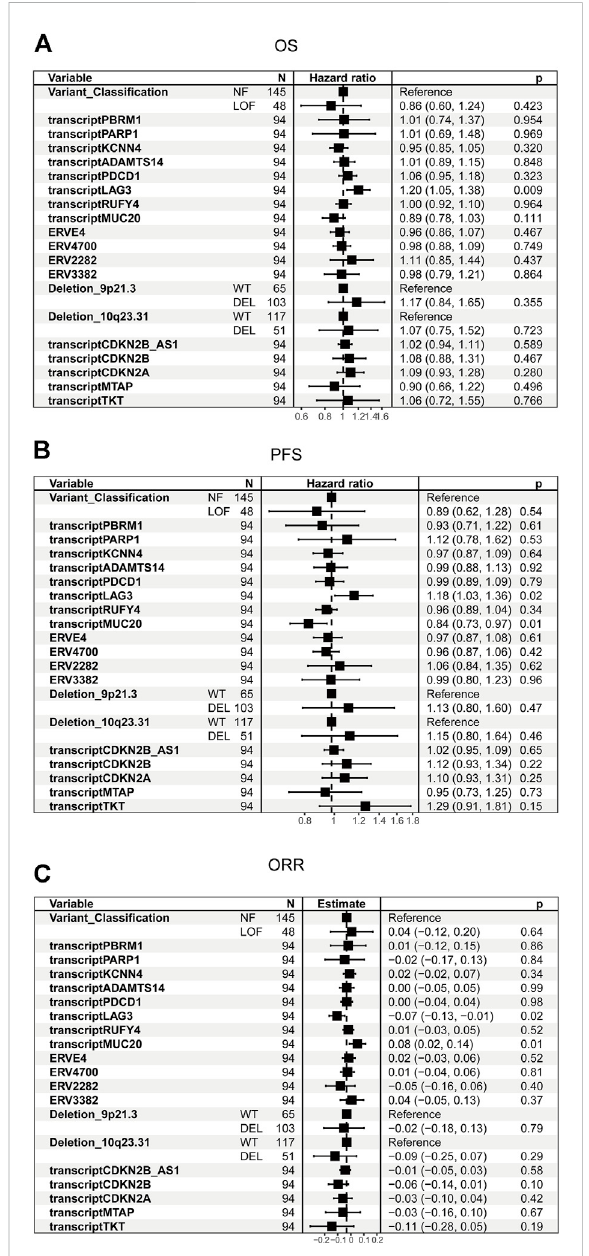
Univariate analysis of candidate biomarkers in the control cohort. (A) The univariate analysis based on Cox regression was used to assess the correlation between OS and candidate biomarkers in the control cohort. (B) The univariate analysis based on Cox regression was used to assess the correlation between PFS and candidate biomarkers in the control cohort. (C) The univariate analysis based on logistic regression was used to assess the correlation between ORR and candidate biomarkers in the control